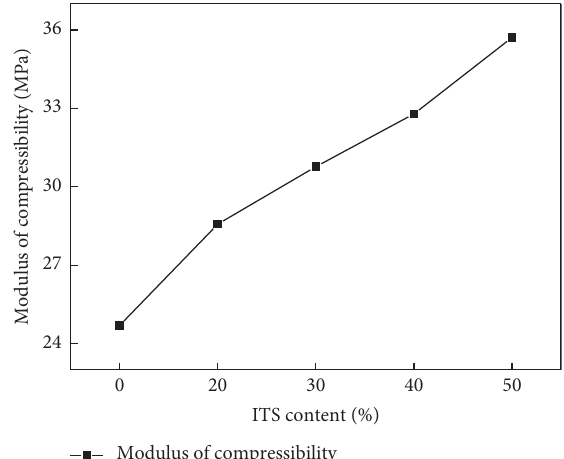
Figure 10: Variations of the compression parameters with ITS